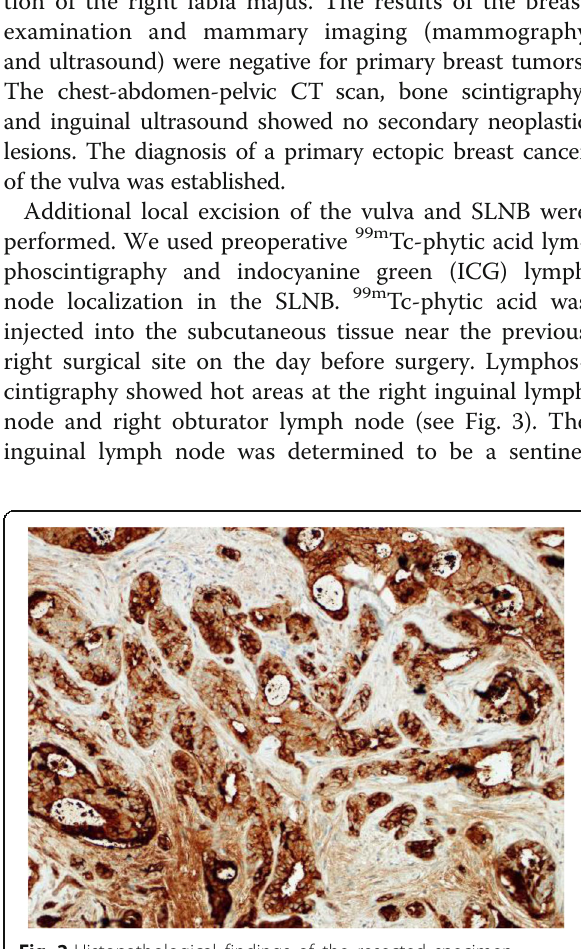
Fig. 2 Histopathological findings of the resected specimen (GCDFP-15 stain, ×200). Positive for GCDFP-15 expression